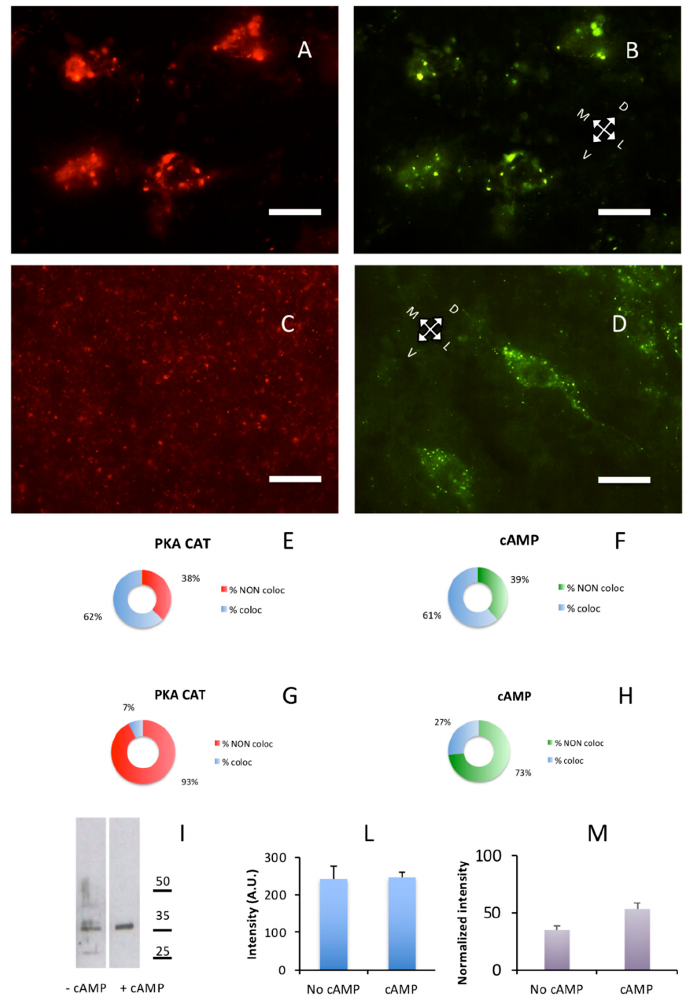
Figure 6. cAMP induces redistribution of PKA catalytic subunit. Coronal sections. Scale bar, 10 µm. ( A ) PKA catalytic subunit immunolabeling in the hypothalamic lateral nuclei. ( B ) Same field as A, Alexa488-cAMP. ( C ) After addition of cAMP for ten min, catalytic subunit (red) relocate as shown by immunolabeling. ( D ) Same field as C, Alexa488-cAMP. E , F : Quantification of superimposition in A and B ( n = 633). ( E ) Percentage of colocalization of PKA catalytic immunolabeling (% coloc, light blue, n = 202) or not (% NON coloc, red, n = 122) with cAMP in A and B. ( F ) Percentage of colocalization of cAMP (% coloc, light blue, n = 190) or not (% NON coloc, green, n = 119) with PKA catalytic immunolabeling in A and B . G , H : Quantification of superimposition in C and D ( n = 1951). ( G ) Percentage of colocalization of PKA catalytic immunolabeling (% coloc, light blue, n = 114) or not (% NON coloc, red, n = 1414) with cAMP in C and D . ( H ) Percentage of colocalization of cAMP (% coloc, light blue, n = 114) or not (% NON coloc, green, n = 309) with PKA catalytic immunolabeling in C and D . ( I ) Western blot of brain soluble fraction before ( − cAMP lane) and after addition of cAMP ( + cAMP lane). Only a partial e ff ect can be appreciated, indicating that addition of cAMP does not completely solubilize the PKA catalytic subunit. Instead, if catalytic subunit is released from regulatory subunit (see also Supplementary Figure S6), it is bound by other complexes, suggesting short-range local interactions. ( L ) Quantification of loading controls for lanes shown in I . Since an e ff ect of cAMP treatment cannot be excluded also for housekeeping gene products, the cumulative intensity of each lane was used as a reference for normalization [30]. ( M ) Protein levels of PKA catalytic subunits ( I ) normalized to loading controls ( L